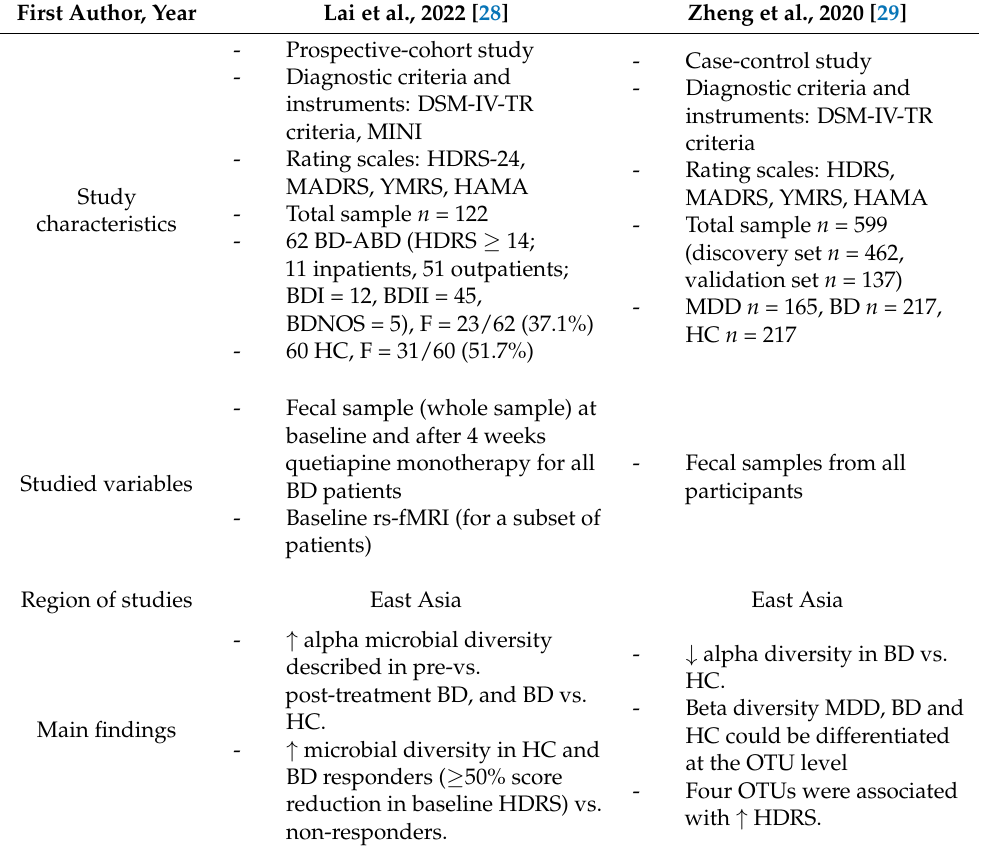
Table 1. Summary of the main findings of the included